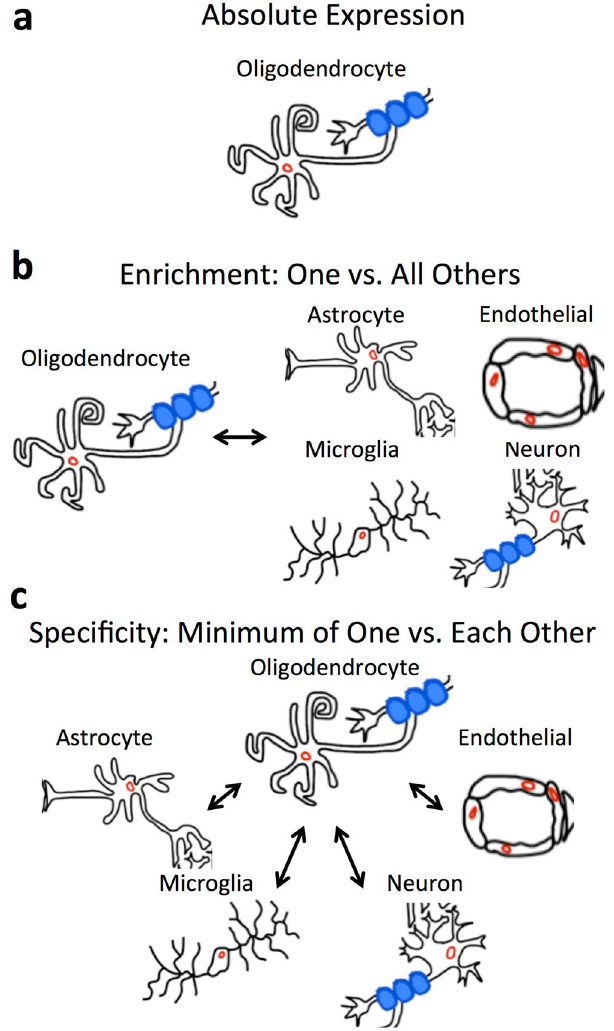
Figure 1. Explanation of the three cell type associated measures. Diagrams showing the three cell type- associated measures used in this study. ( a ) Cell type absolute expression simply measures the relative expression of each gene in each cell type, irrespective of the expression of that gene in other cell types. ( b) Cell type enrichment measures the expression of each gene relative to the expression of that gene in all other cell types. With this measure, a gene could have relatively high expression in two cell types, and be relatively enriched in each of them compared to all other cell types. ( c) Cell type specificity measures the expression of each gene relative to the highest expression of that gene in all other cell types. This measure requires that the expression of the gene is only high in one cell type; therefore, we call it